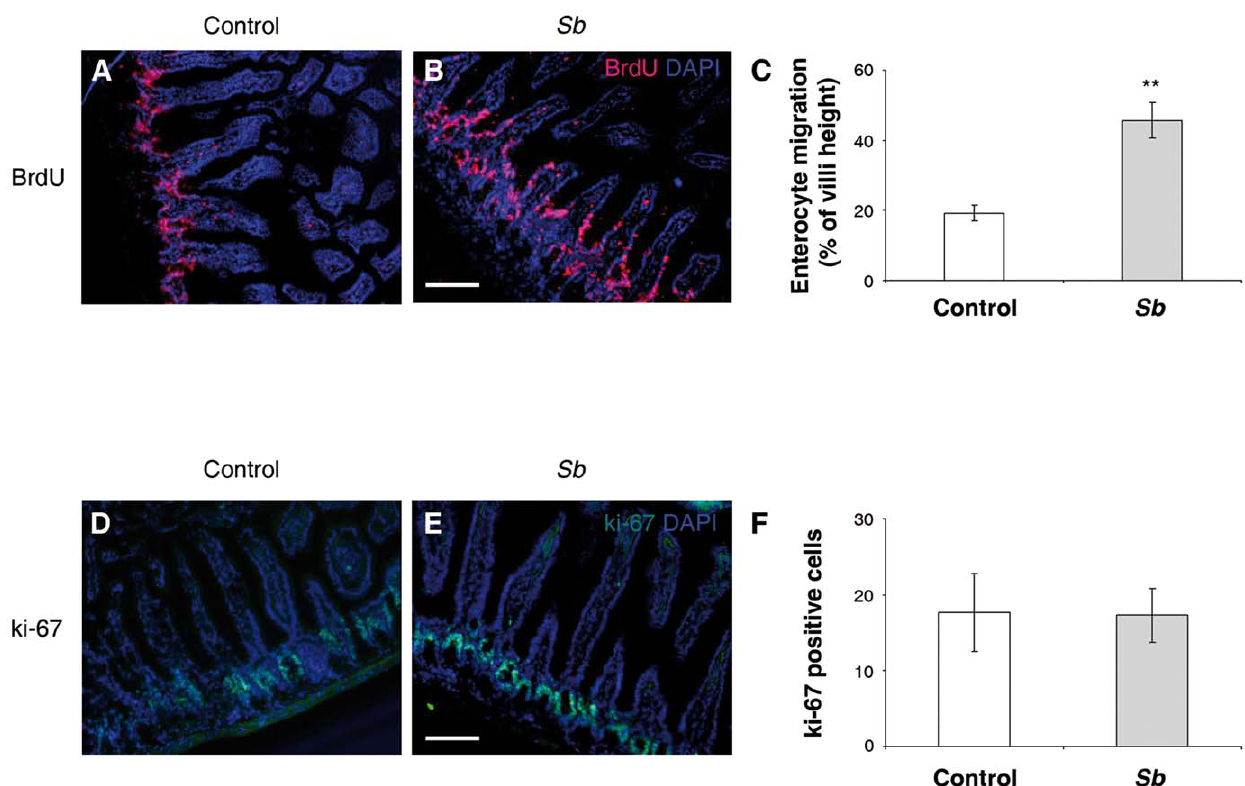
Figure 3. Sb improves mouse enterocyte migration along the crypt-villus axis without affecting crypt cell proliferation. Control and force-fed Sb mice were injected with BrdU 24 hours before sacrifice. Small intestinal tissues were processed for immunostaining. The BrdU-labeled enterocyte migration along the crypt-villus axis was traced on tissue sections by immunostaining with an anti-BrdU Ab ( A and B ) and quantitatively assessed ( C ) as described in Methods. (n=5). ** P , .01. The proliferative marker ki-67 was detected in small intestine of control ( D ) or Sb force-fed mice ( E ) and the number of ki-67 positive cells per crypt were evaluated ( F ) (n=5). Scale bar: 150 m m.